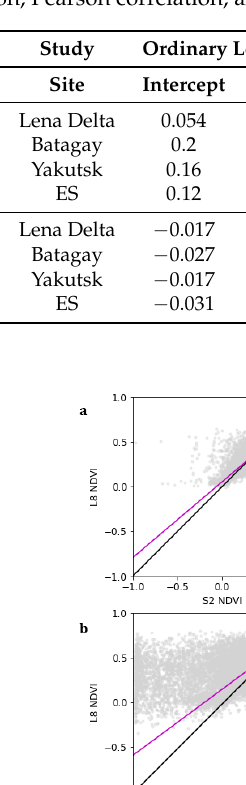
Table 5. Comparison of NDVI calculations from Sentinel-2 and Landsat-8 before and after spectral band adjustment (NDVI adj), for same-day acquisitions. Displaying the results of the ordinary least squares regression, Pearson correlation, and root mean squared error for every study site.